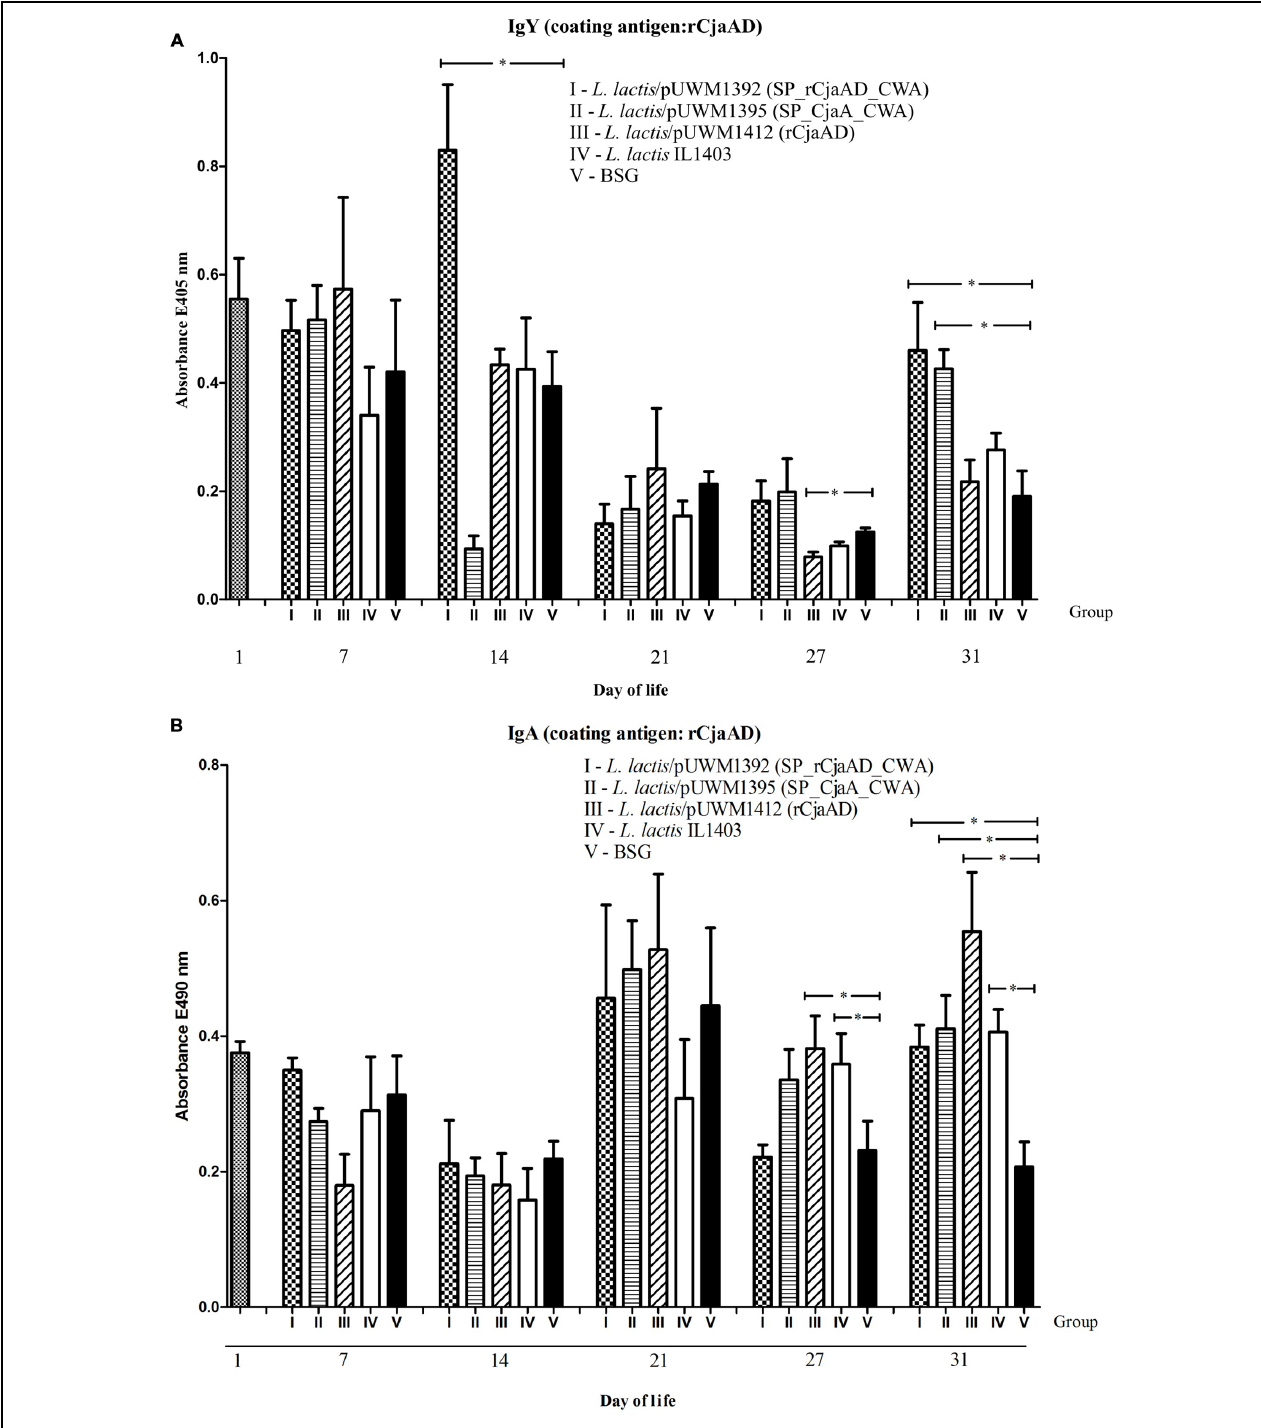
FIGURE 7 | Immune responses of chickens vaccinated with L. lactis strains ( L. lactis /pUWM1392, L. lactis /pUWM1395 and L. lactis /pUWM1412). Levels of serum IgY (A) and mucosal sIgA (B) antibodies specifically recognizing CjaA or rCjaAD antigens were determined by ELISA. Chickens were given three doses of the vaccine strains at 1, 8, and 17 days post-hatch. Birds were infected with C. jejuni at 22 day of life. Control birds were given L. lactis IL1403 strain (open bars) or BSG (black bars). Serum and intestinal samples were collected at the specified days of chicken life. Purified rCjaAD protein was used as a coating antigen. Serum samples were diluted 1:256 and intestinal secretion samples 1:10. Absorbance values represent a mean of 5 birds ± SD per time interval. A statistical analysis was carried out using the Kruskal–Wallis test followed by Dunn’s multiple-comparison post hoc test. An asterisk indicates significant difference ( p < 0.05) between groups and control group (group V).